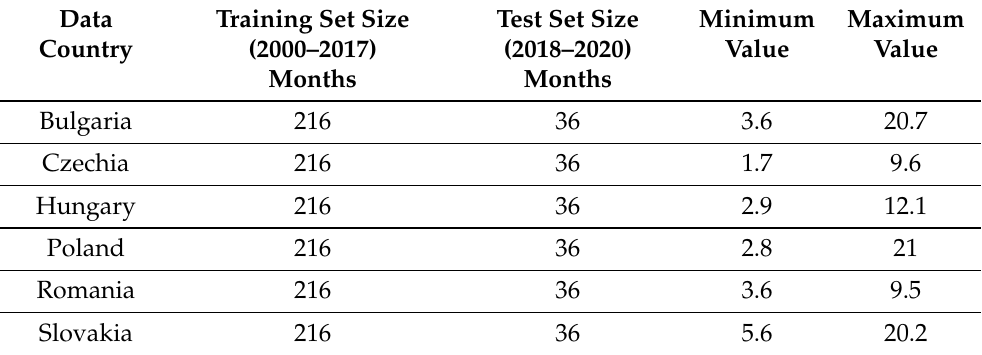
Table 2. Summary of the unemployment rate dataset.